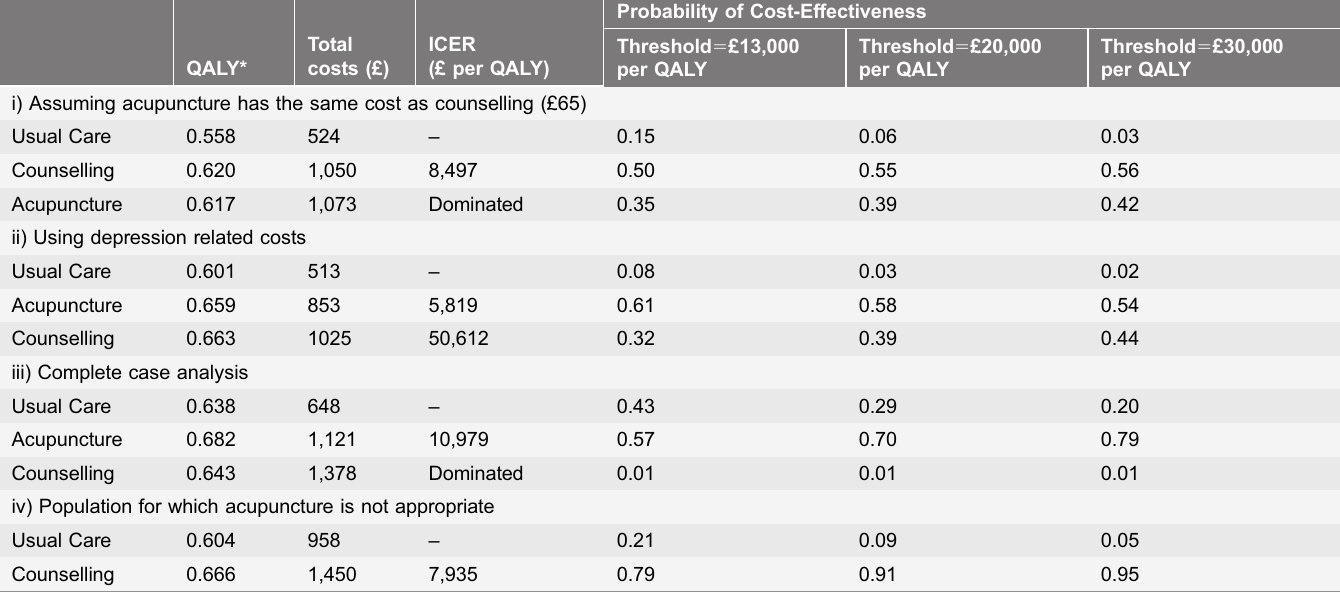
Table 6. Incremental cost-effectiveness scenario